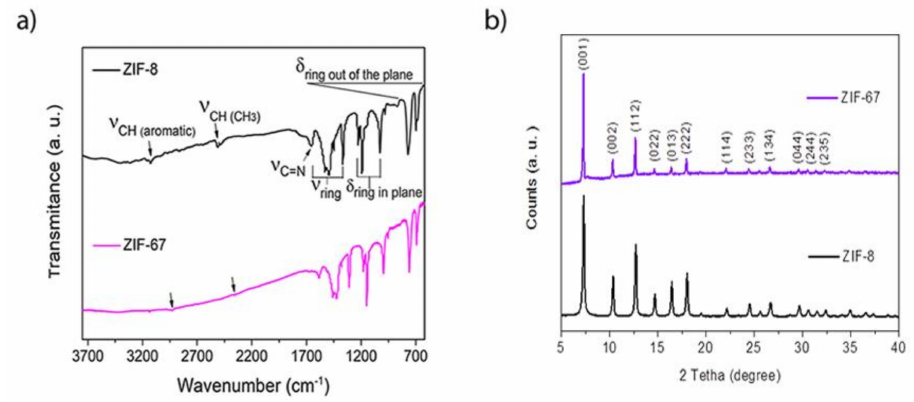
Figure 5. ( a ) FTIR spectra of the ZIF-8 and ZIF-67 samples diluted in KBr. ( b ) 2- XRD Powder Pattern of the ZIF-8 and ZIF-67 samples.